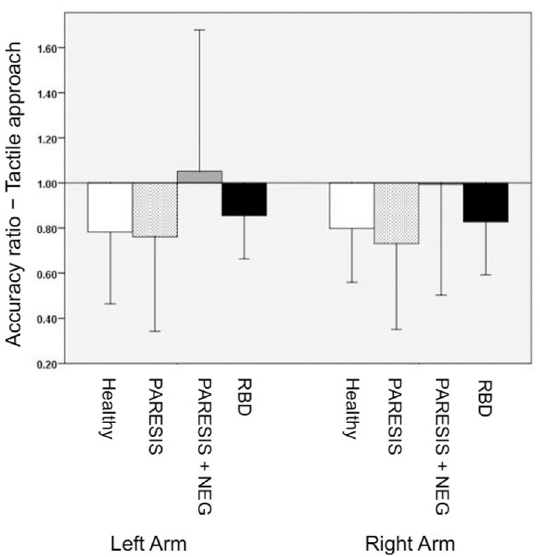
for both sides (right body side: F (3, 17.73) = 3.89, p = .027; left body side: F (3, 15.292) = 4.881, p = .014). For the right body side, pairwise post-hoc Dunn tests with Bonferroni-Holm- correction revealed only one significant difference between paretic patients without neglect vs. right brain damaged controls (p = .002). For the left body side, pairwise post-hoc Dunn test with Bonferroni-Holm-correction were significant for paretic patients without neglect vs.